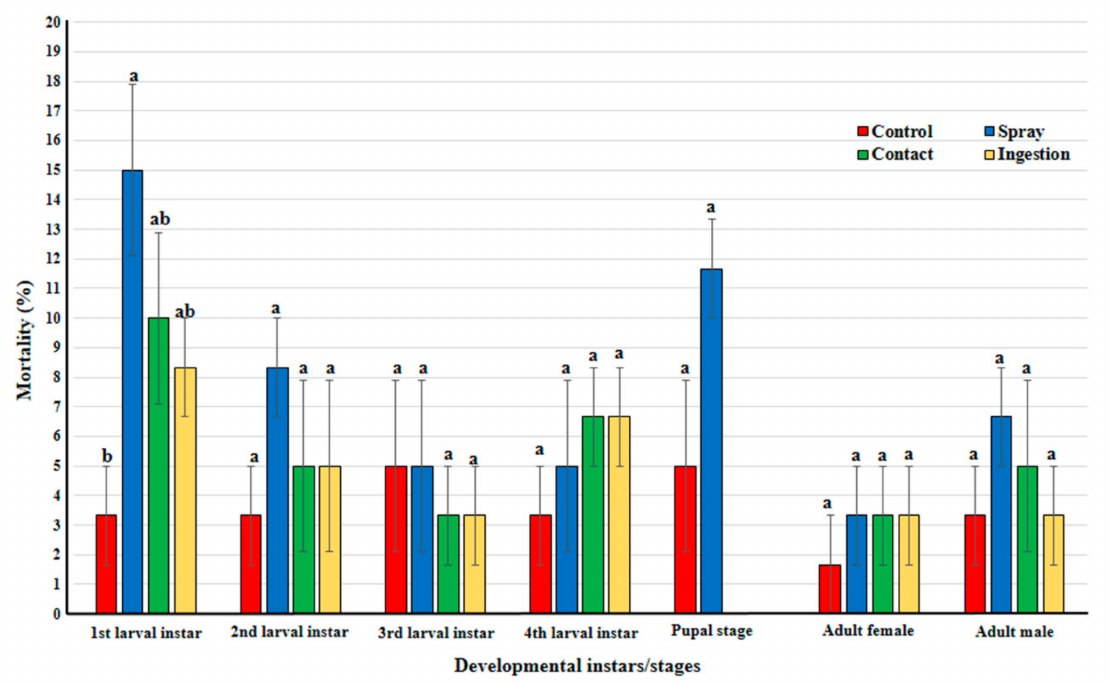
Figure 1. Percent mortality of larva, pupa, and adults of Hippodamia variegata treated with three different applications with Beauveria bassiana. Different letters above bars indicate significantly different means according to Duncan test ( α = 5%) except of pupal stage with t -test ( α =